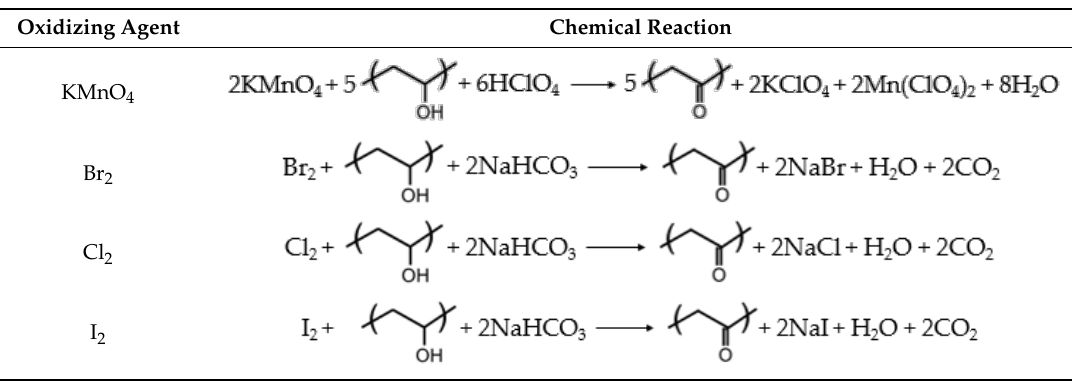
Table 1. Partial oxidation of PVA. Chemical schemes representing the reactions for PVA oxidation with different agents.